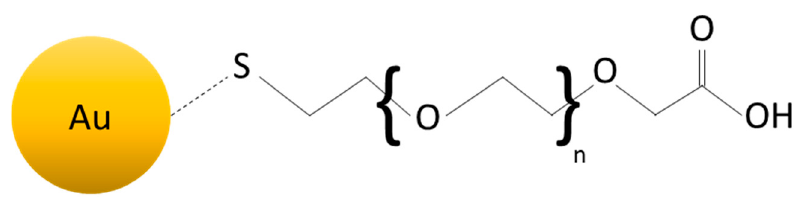
Figure 10. Example of Au-NP functionalized with thiol-carboxyl group.